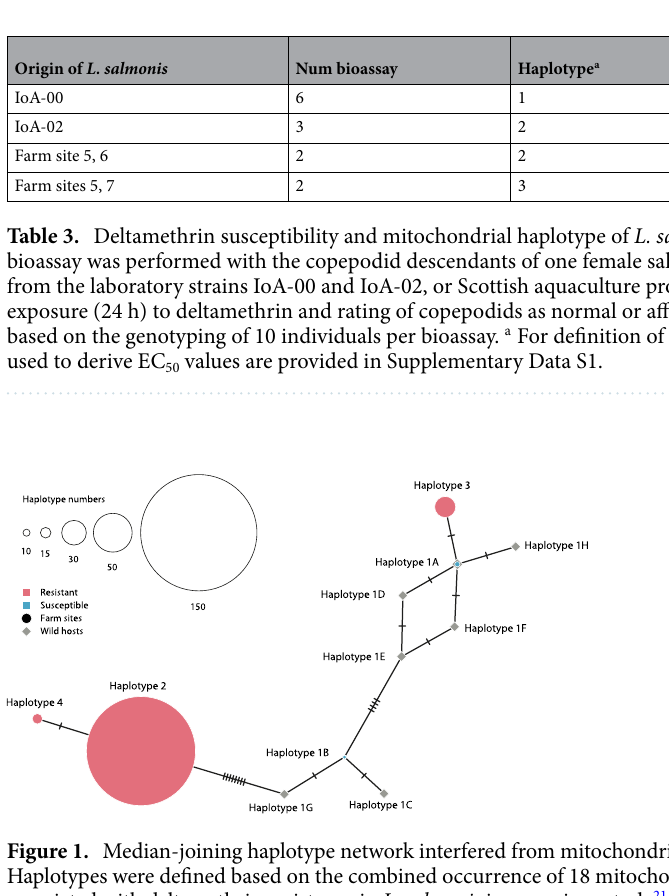
(Supplementary Table S10). Comparison of the mtDNA genome of IoA-10 strain lice to that of DTM resistant and susceptible L. salmonis strains (IoA-00, IoA-01) revealed a limited number of mtDNA mutations that were present in all DTM resistant lice while lacking in all analysed susceptible isolates. These mutations comprised